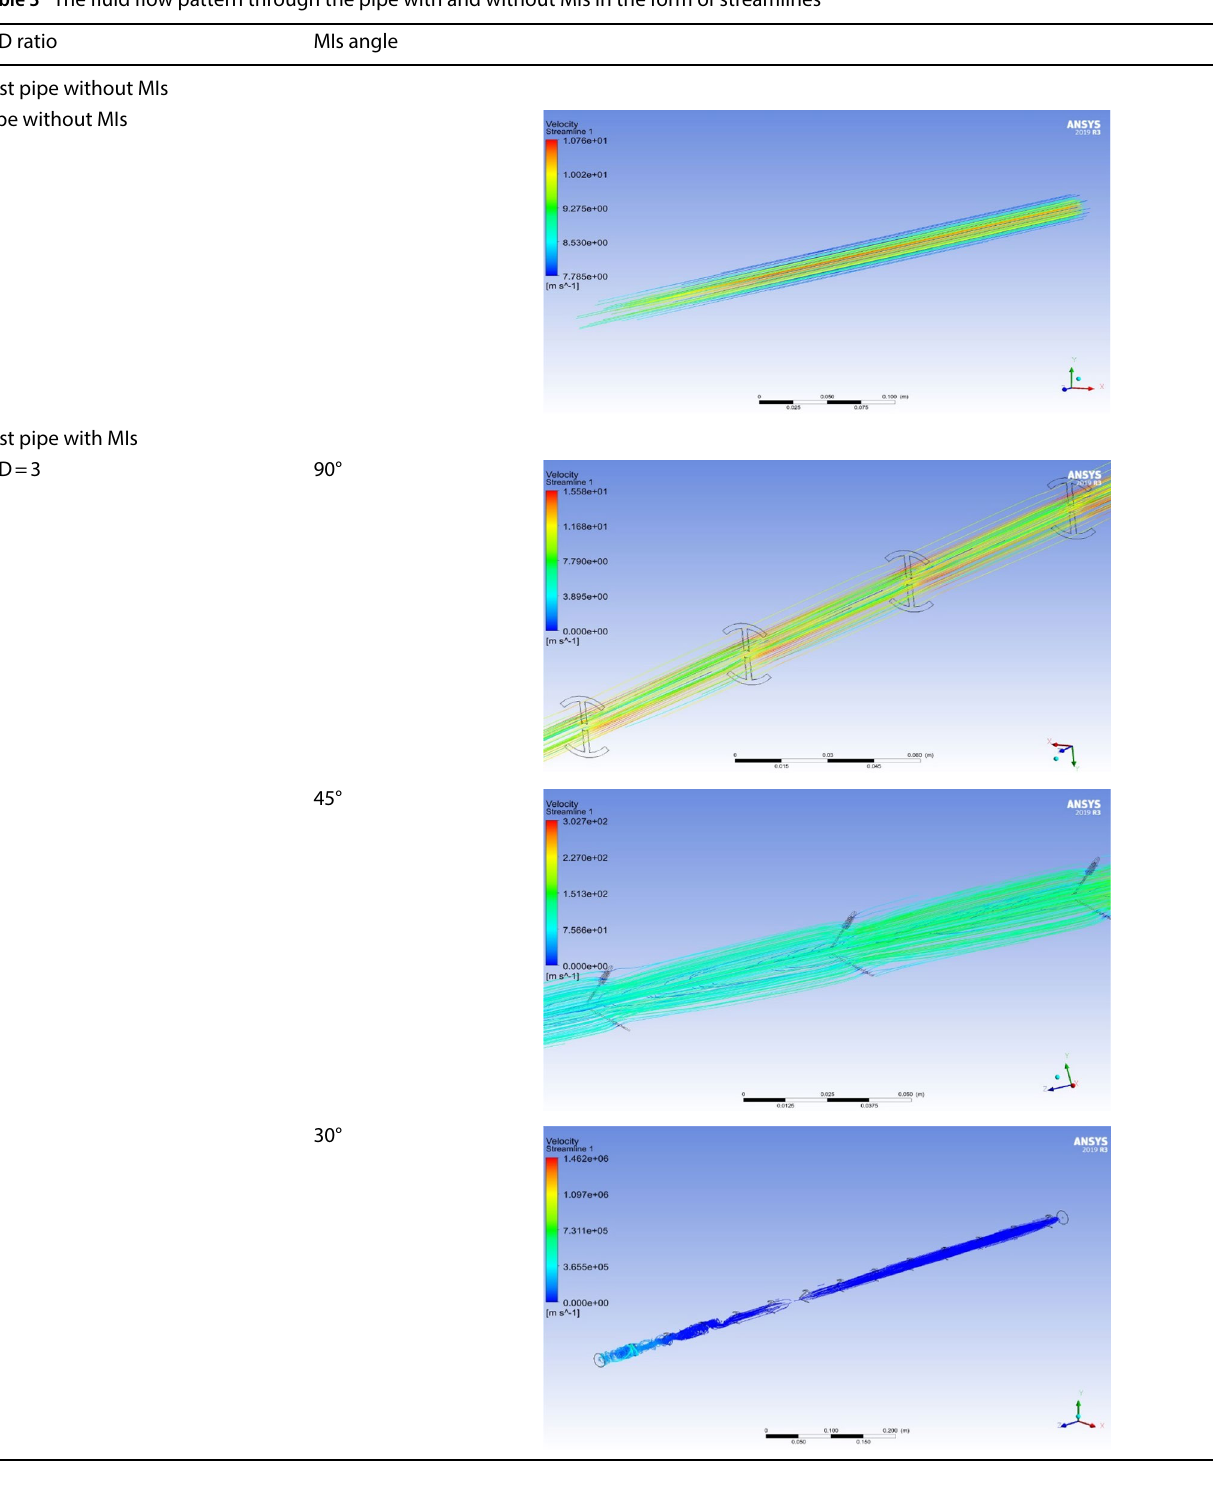
Table 3 The fluid flow pattern through the pipe with and without MIs in the form of streamlines P/D